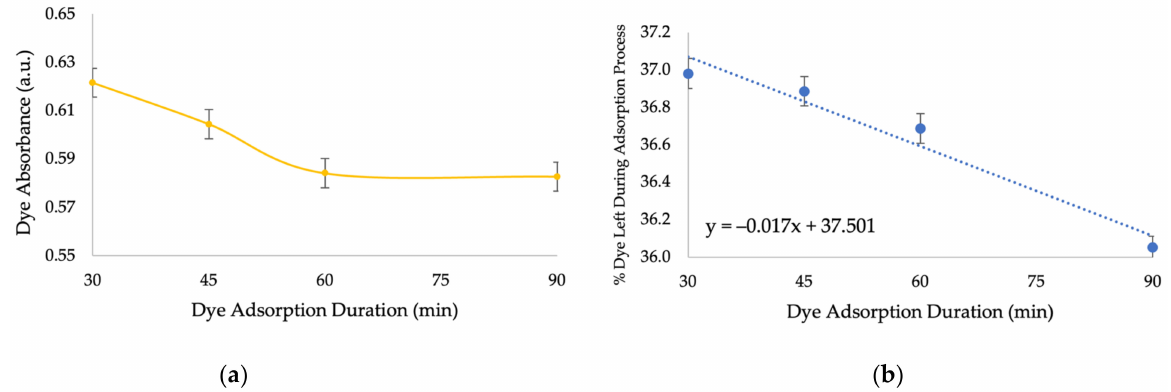
Figure 10. The absorbance signal of acid red 131 dye over time when it is mixed with crude NC for 30, 45, 60, and 90 min ( a ) and acid red 131 dye’s content over time during its adsorption by crude NC ( b ). Initial concentrations: 0.1 ppm dye and 1 ppm crude